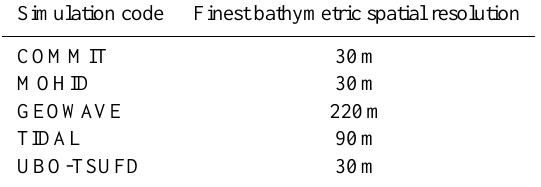
Table 2. Resolution of the bathymetry data sets used during the benchmarking of 5 different modelling tools presented in Sect. 3.1 and Fig. 2: COMMIT (Cornell University), MOHID (MARETEC, Lisbon, Portugal), GEOWAVE (Watts et al., 2003), TIDAL (ACRi Software Tools), UBO-TSUFD (Tsunami Research Team of the University of Bologna, Italy).